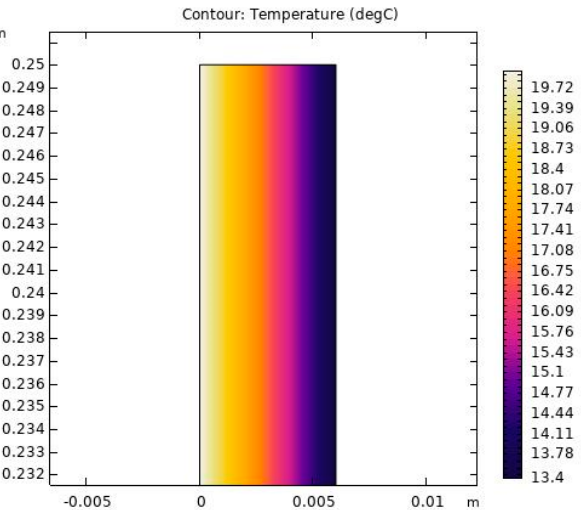
Figure 3. Heat flux variation through the windows of the bus.